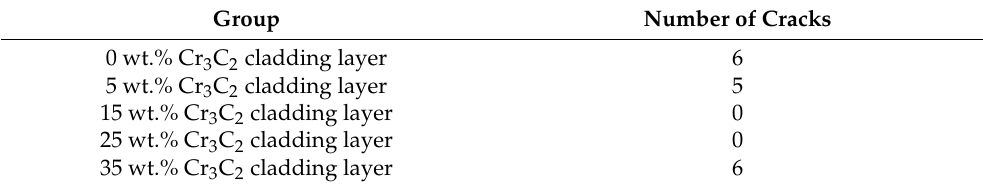
Table 2. The number of cracks generated in samples of different cladding materials of the same length (15 cm). Group